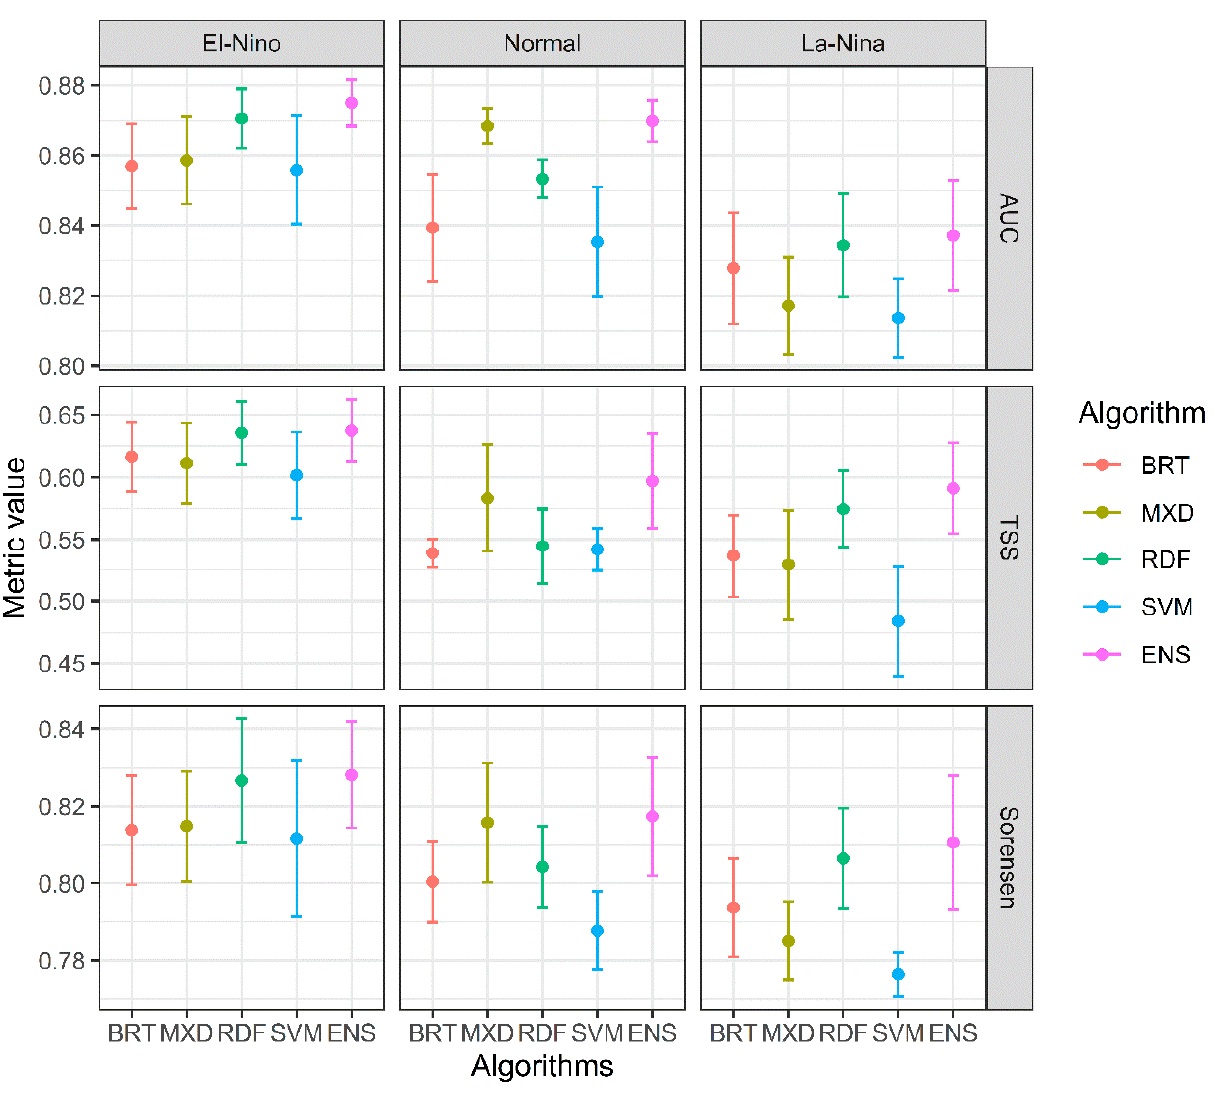
Figure 4. Box and whisker plots depicting the effects on discrimination metrics related to fire vulnerability algorithms. The whisker represents the mean ± standard deviation, and the box represents the mean ± standard error (BRT, boosted regression tree; MXD, maximum entropy; RDF, random forest; SVM, support vector machine; ENS, ensemble).